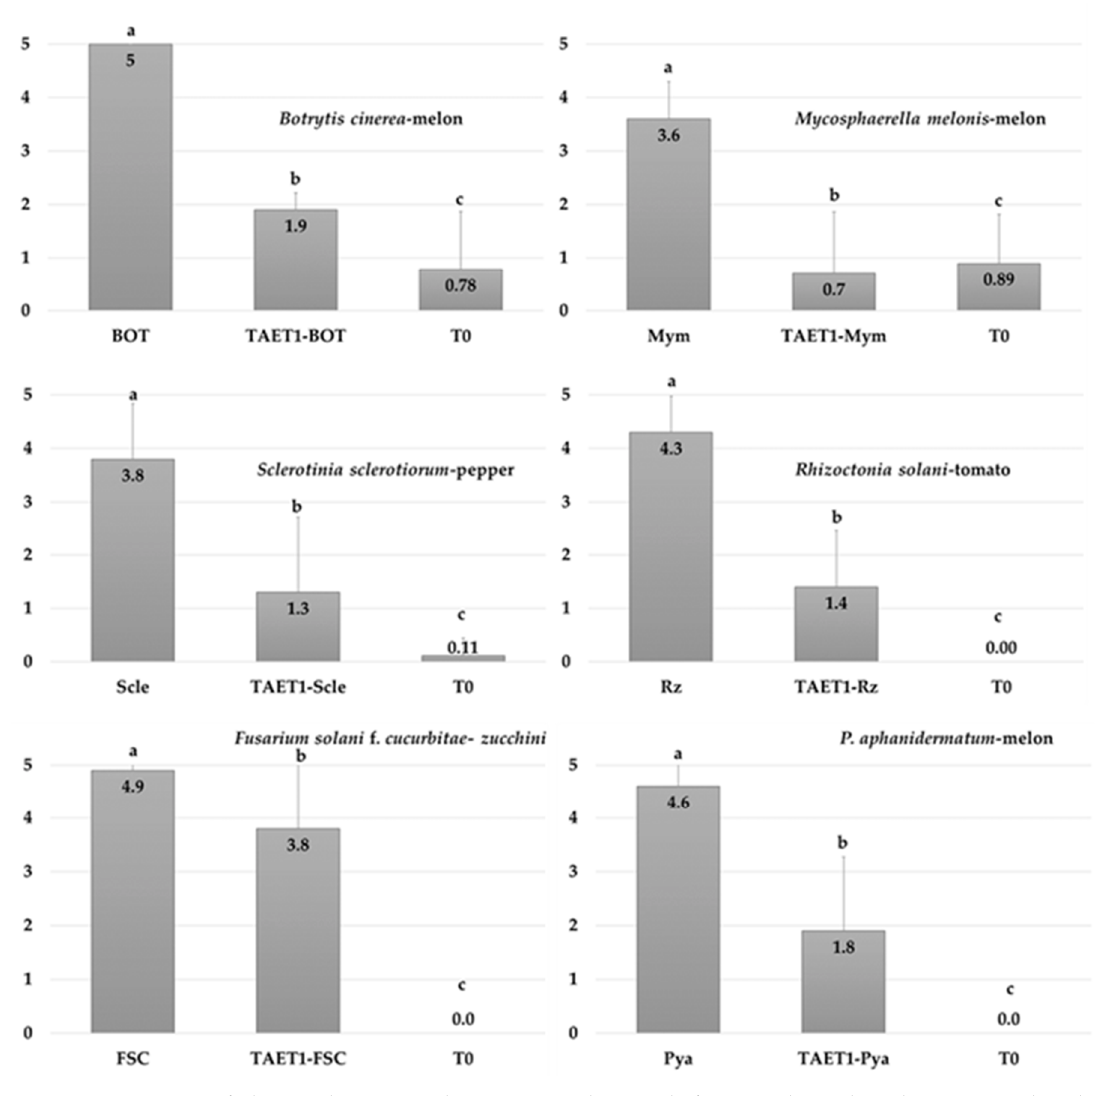
Figure 6. Disease severity of phytopathogens in plants was rated 30–90 d after inoculation based on a 0–5 scale: where 0 = no visible disease symptoms and 5 = plant dead. T0: control; TAET1: T. aggressivum f. europaeum TAET1; Bot: B. cinerea ; Mym: M. melonis ; Scle: S. sclerotiorum ; Rz: R. solani ; FSC: F. solani f. cucurbitae ; Pya: P. aphanidermatum . Mean standard deviation is expressed by error bars (24 plants per repetition). Means with the same letter are not significantly different (LSD) according to the ANOVA ( p < 0.05).